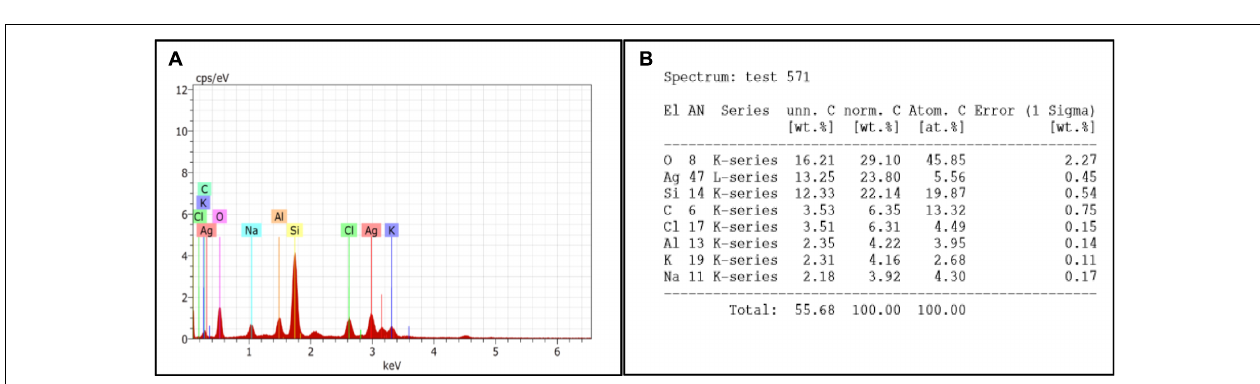
FIGURE 7 | (A) EDS graph represents the count second on x -axis and the kilo electron volt on which it is generated is on y -axis. (B) Showing percentage of elements present in treated biofilm.